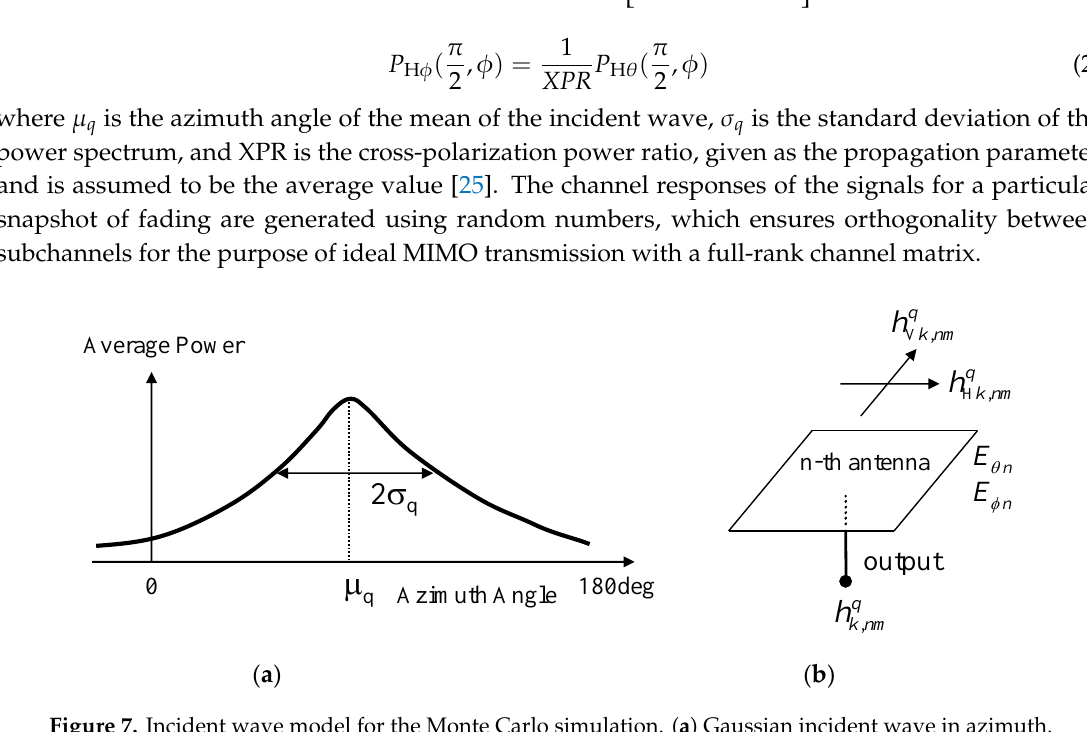
Figure 7. Incident wave model for the Monte Carlo simulation. ( a ) Gaussian incident wave in azimuth. ( b ) Two polarization components.